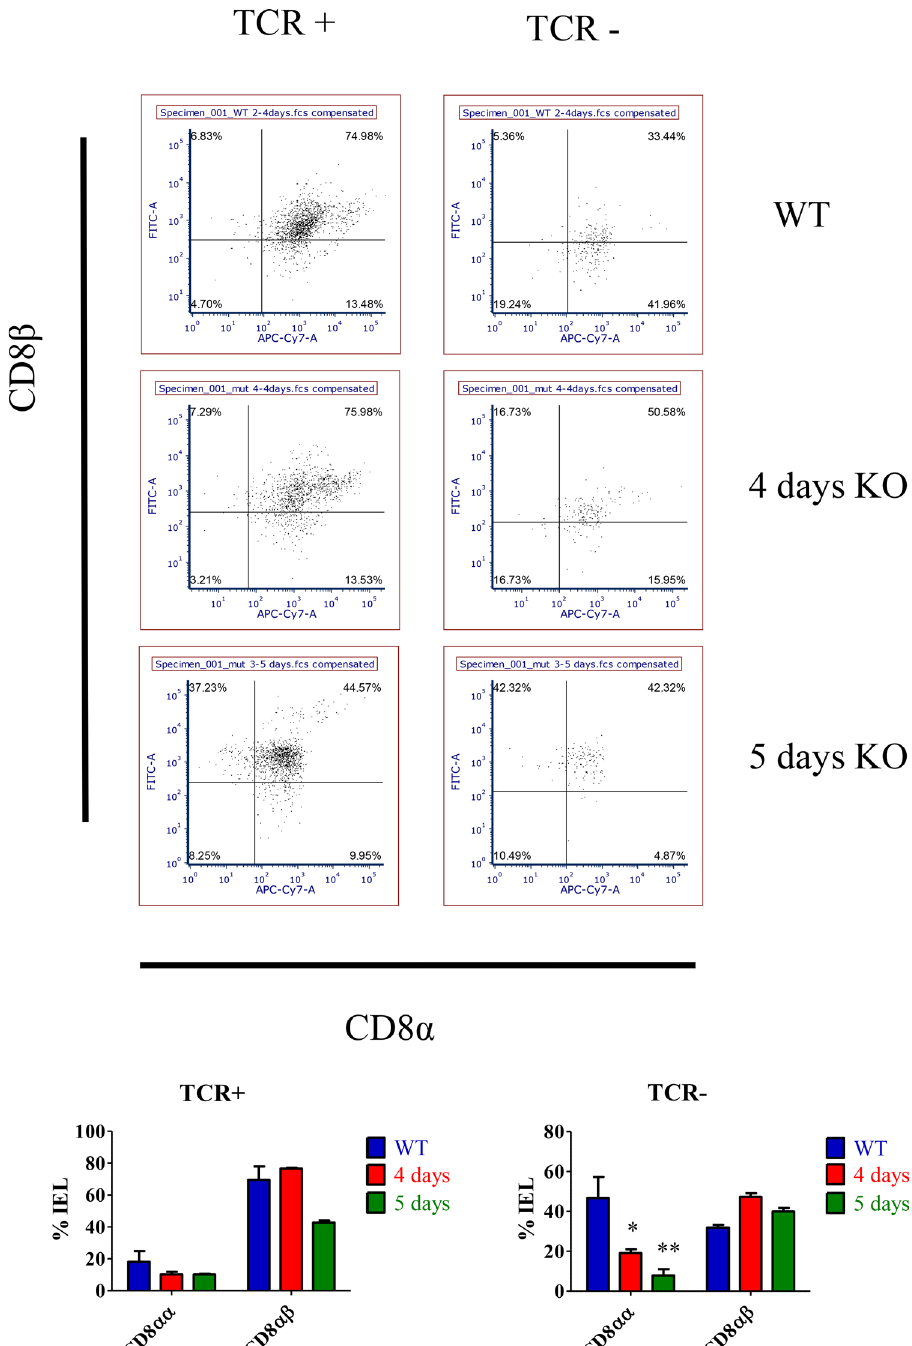
Figure 5. Cdx-dependent immune cell recruitment. Intestinal epithelial and associated cells were collected 4 or 5 days post-tamoxifen treatment and CD45-positive populations analyzed by flow cytometry. Scatter plots of CD45 cells sorted as either TCR+ or TCR- based on TCRβ expression, assessed for CD8α vs CD8β, CD4 vs F4/80, CD11C and CD206 to differentiate inflammatory vs anti-inflammatory macrophages, CD8αα cells were depleted at both time points (lower panels), * p ≤ 0.05; ** p < 0.01; *** p < 0.001 by